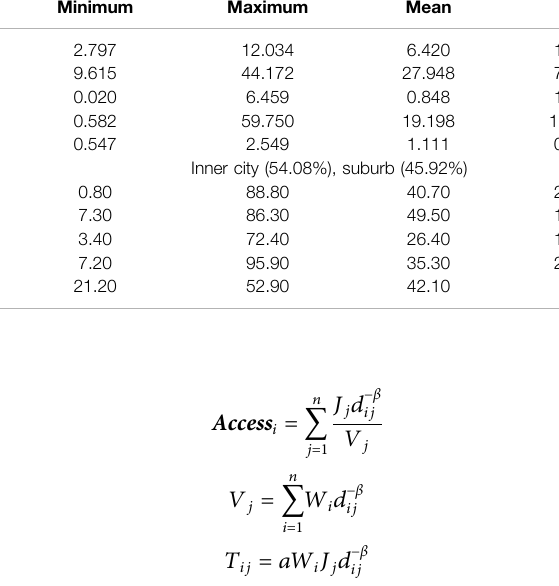
TABLE 1 | Descriptive statistics of variables.